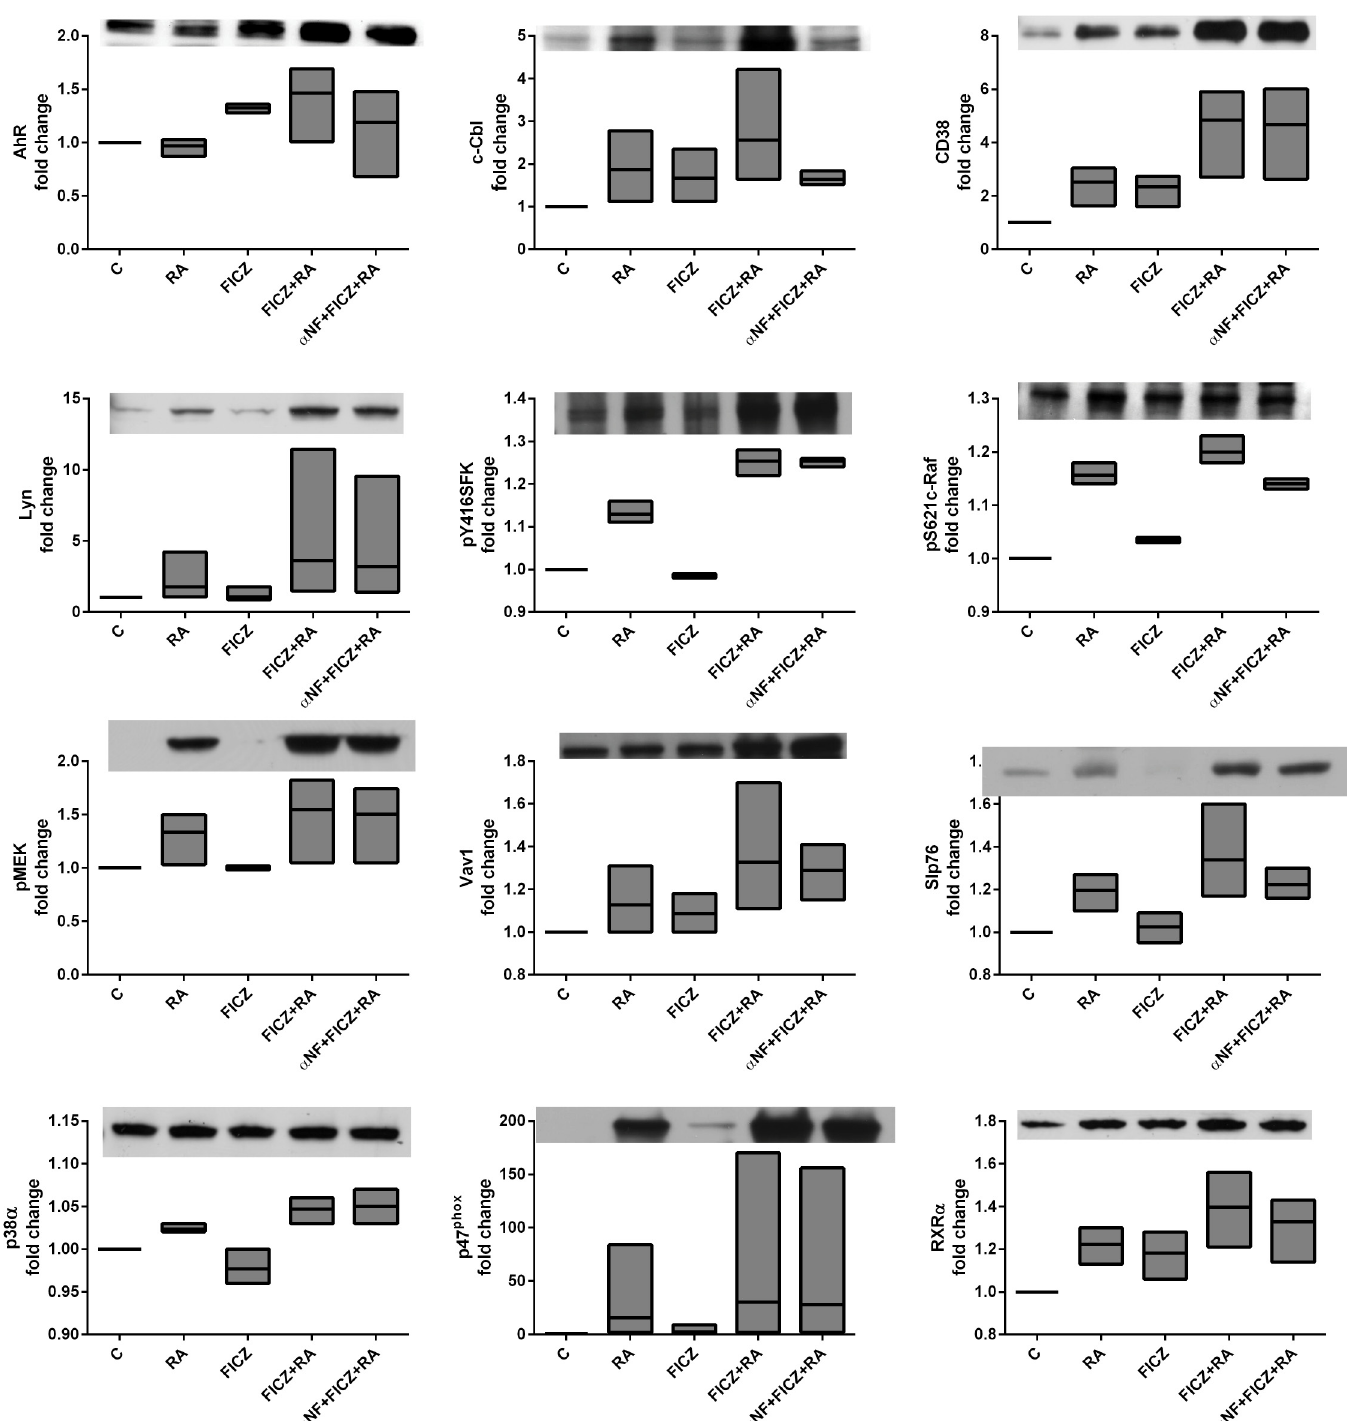
Fig 8. FICZ has effects beyond classical AhR transcriptional regulation. HL-60 cells were initiated in culture at 0.1 x 10 6 cells/ml with 1 μ M RA, 100 nM FICZ, 1 μ M α -NF and 1 μ M β -NF as indicated. Western blot assays of whole cell lysates are shown. Whole cell lysates were collected after 48 h. Lysates were resolved on a 12% polyacrylamide gel. 25 μ g of protein was loaded in each well. Experiments were repeated at least three times. All the western blot data were quantified using ImageJ, normalized to GAPDH and then to untreated control and graphed as min to max floating bars with a line at the mean using GraphPad Prism software. P-value analysis cannot be performed on quantified blot data as this data is non-linear. A representative blot is shown for each marker.